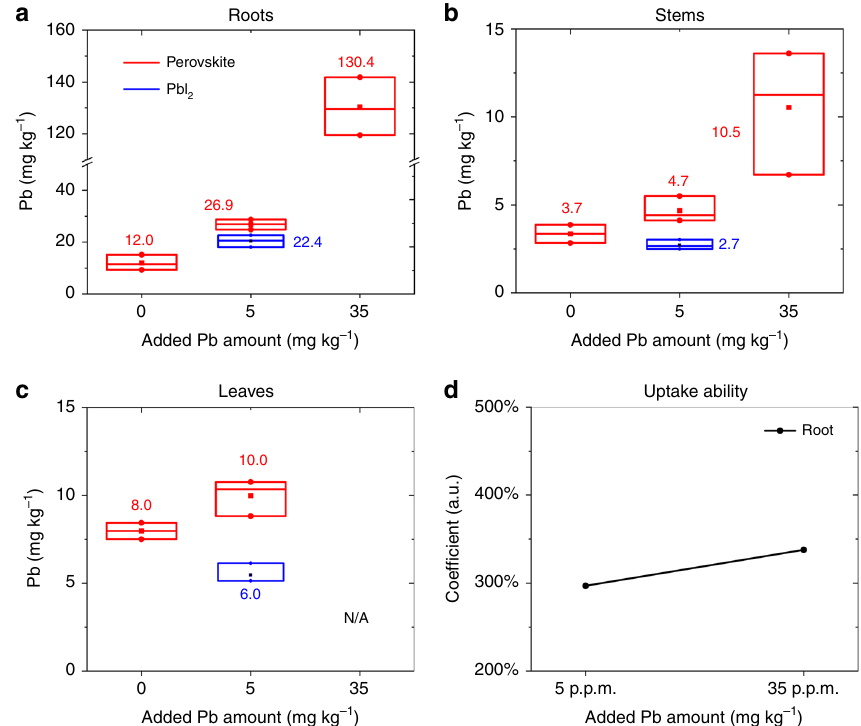
Fig. 2 Lead concentration in different parts of mint plants. a Roots, b stems, and c leaves. The lead uptake ability ( η , de fi ned in Eq. 1) is reported in d . Data for lead concentration in leaves at 35.0 mg kg − 1 are not available (N/A) as plants did not produce enough leaves at such a high level of lead. The maximum, minimum, and mean value of each distribution are reported in a – c .